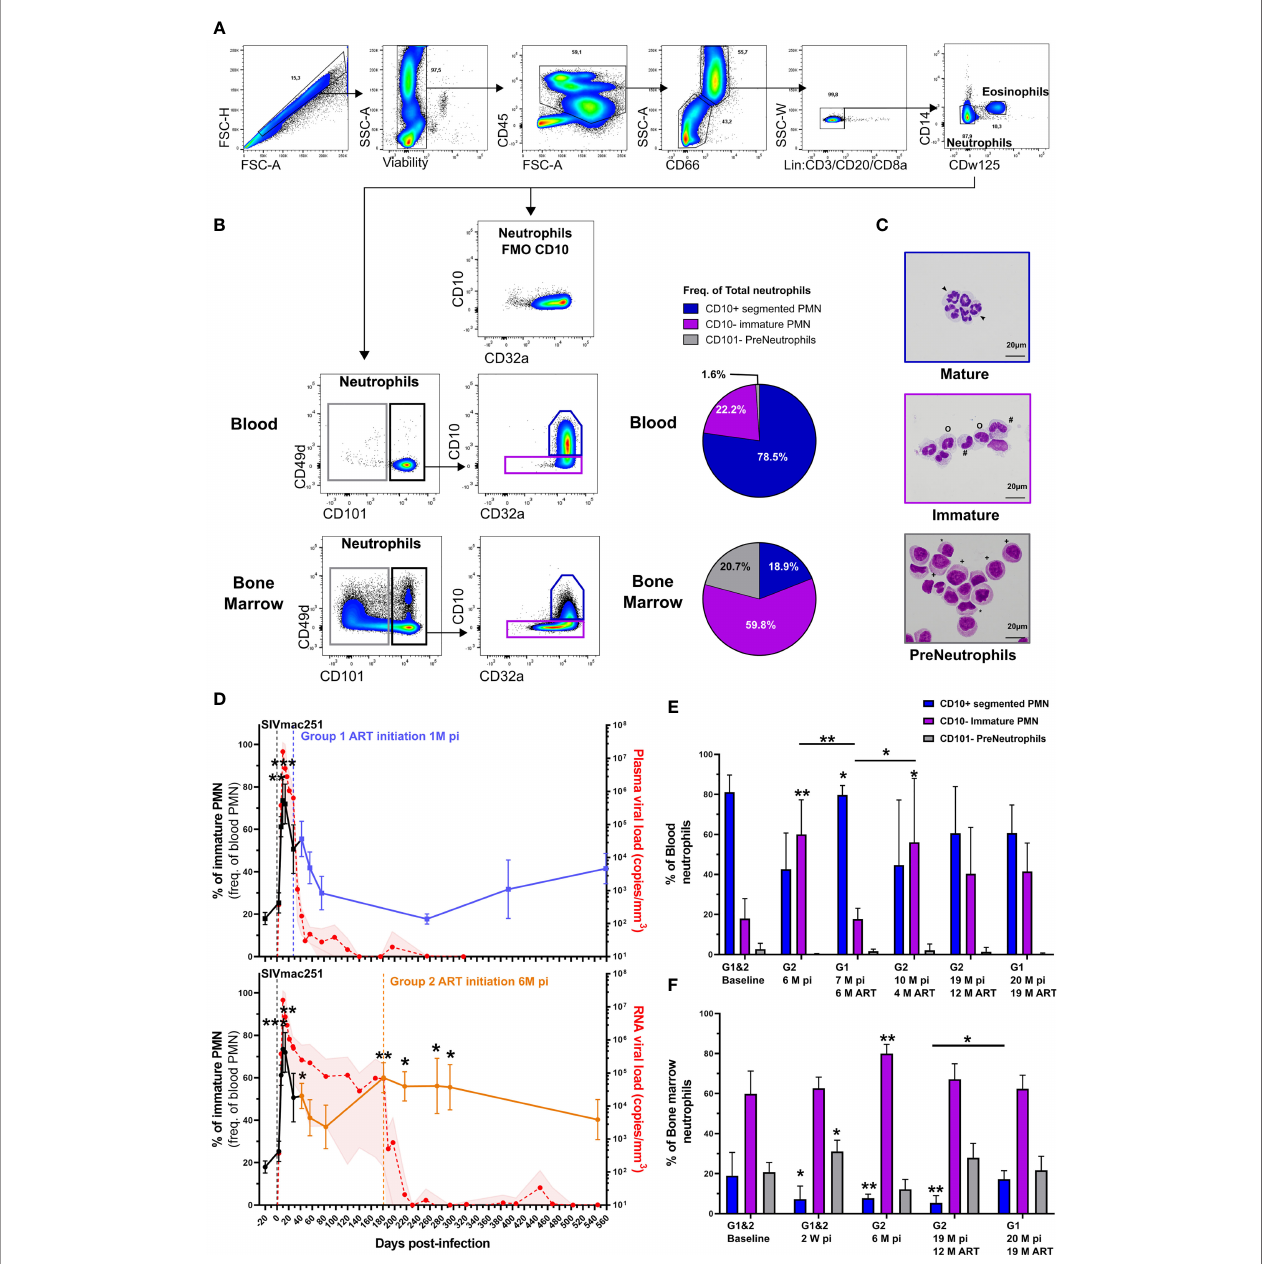
FIGURE 2 | Circulation of immature neutrophils in primary and chronic SIV infection. (A) Gating strategy used to identify neutrophils in blood and bone marrow from cynomolgus macaques. Neutrophils were identi fi ed as CD45+ SSC-A+ CD66+ lin- CD14- and CDw125-. (B) Gating strategy with representative plots of different neutrophil maturations stages obtained in blood and bone marrow from a healthy cynomolgus macaque. Brie fl y, pre-neutrophils were gated on CD101- neutrophil population and mature CD10+ and immature CD10- neutrophils were then gated on CD101+ cells. Full minus one (FMO) staining of bone marrow for CD10 is also shown. Pie charts representing the distribution of different neutrophil maturation stages in bone marrow and blood from healthy cynomolgus macaques. (C) Representative cytology of corresponding cells obtained after FACS sorting on blood and bone marrow. CD101 - pre-neutrophils were composed of promyelocytes ( + ) and myelocytes ( * ). The CD101 + fraction was composed of immature CD10 - ( # : metamyelocytes, o : band cells) and mature CD10 + ( arrow : segmented PMNs) PMNs. (D) Frequency of immature PMNs in the blood during SIV infection and treatment in Group 1 and Group 2. Before cART initiation for Group 1, both groups are represented together in a black line during the fi rst month and then separated. The values in the graphs indicate the mean with the SD for both groups, p-value indicates a signi fi cant difference to baseline, with *p < 0.05, **p < 0.01, ***p < 0.001 by the paired Friedman test with Dunn ’ s multiple comparison. (E, F) Frequency of each PMN maturation stage in the blood and bone marrow during SIV infection. Symbol * indicates a signi fi cant difference to baseline in the same group and the bar represent a signi fi cant difference between two groups, with *p < 0.05, **p <0.01, ***p < 0.001 by the paired Friedman test with Dunn ’ s multiple comparison and Mann Whitney tests for unpaired